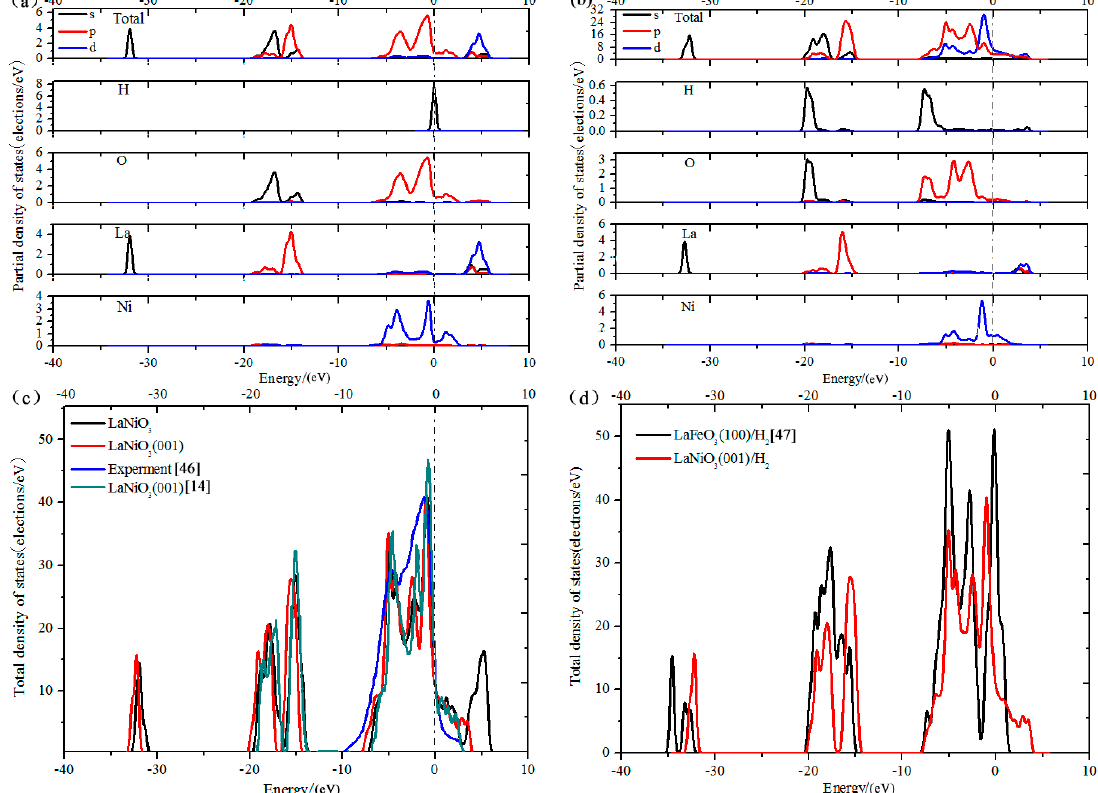
Figure 5. Total and partial densities of state of LaNiO 3 (001)/H 2 on B3. ( a ) Density of states (DOS) before adsorption; ( b ) DOS after adsorption; ( c ) The theoretical calculation and experimental results [14,46]; ( d ) Comparison of total densities of state of LaNiO 3 and LaFeO 3 [47]. B3 represents the adsorption site of H 2 molecule in the O–O Bridge.